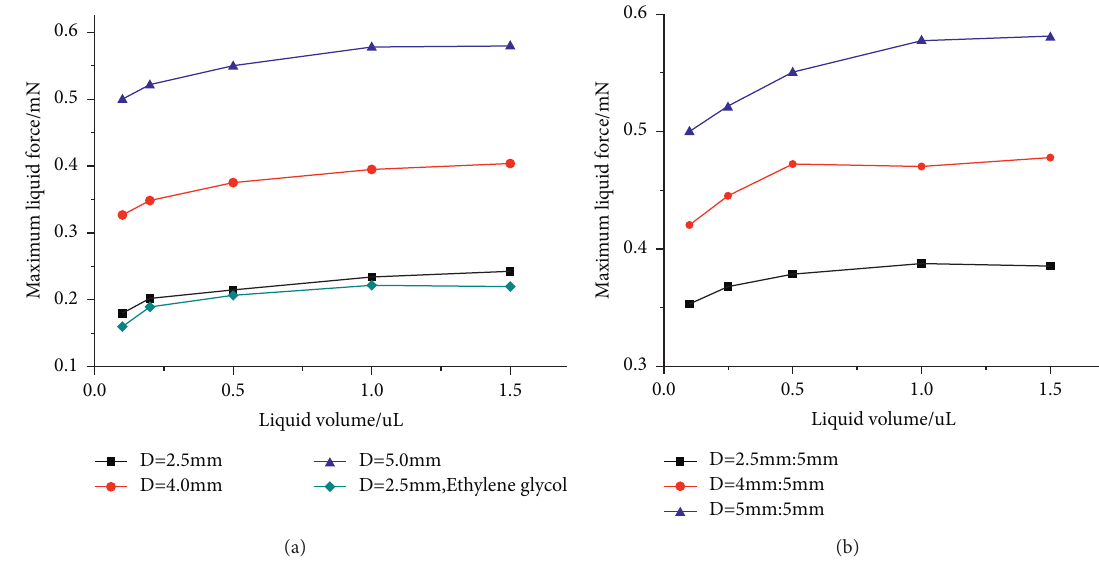
Figure 4: The maximum liquid force-liquid volume curves. (a) equal particles; (b) unequal